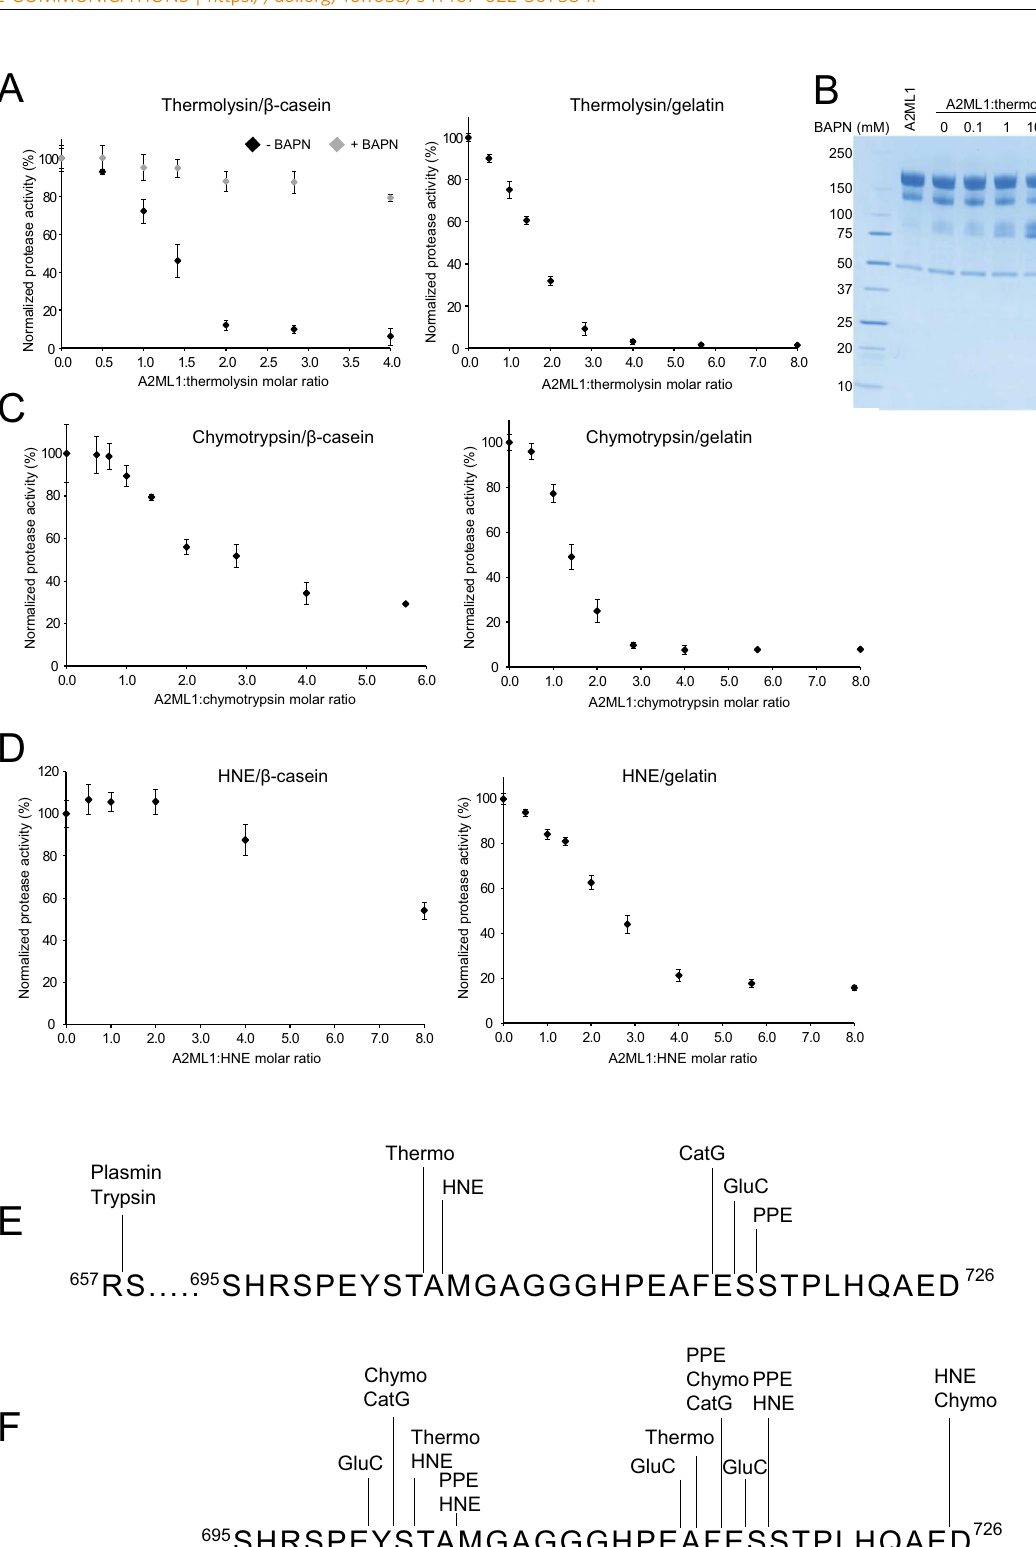
(PPE), and trypsin in the presence and absence of BAPN (Sup- plementary Fig. 2B). SDS-PAGE analysis showed that PPE cleaves A2ML1 into distinct N- and C-terminal fragments, while the N- and C-terminal fragments were dif fi cult to distinguish for chy- motrypsin (Supplementary Fig. 2B), and only one band con- taining the C-terminal part of A2ML1 was evident after trypsin cleavage. The addition of BAPN signi fi cantly increased the NATURE COMMUNICATIONS| (2022) 13:3033